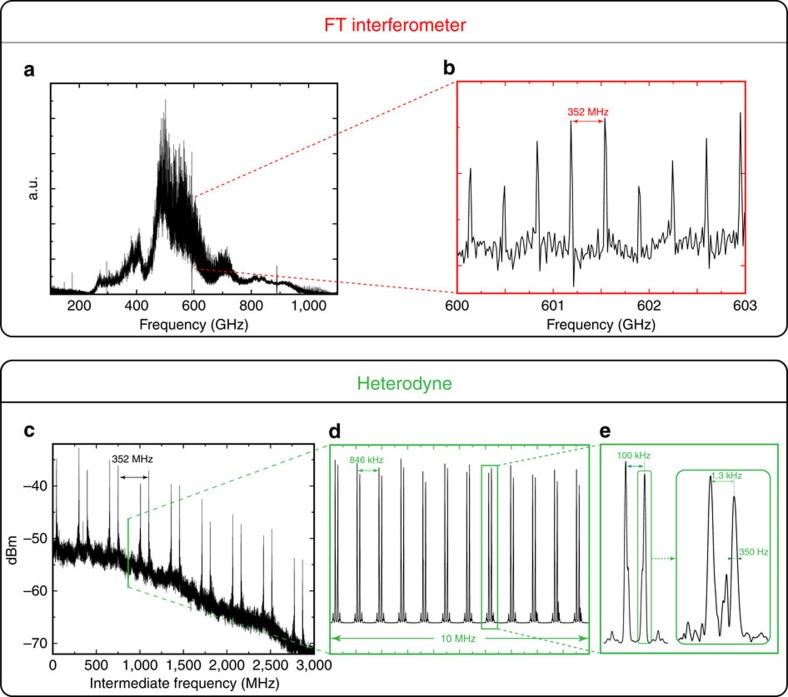
CSR FC structure recorded using the FTIR interferometer and heterodyne receiver.All amplitude scales are linear unless stated otherwise. Heterodyne frequency scales are established as a function of the intermediate frequency. (a) Full range of the CSR measured by the FTIR interferometer with a resolution of 30 MHz; the low-frequency response is limited by the optical elements of the instrument. (b) Zoom of 3 GHz revealing the 352 MHz FC corresponding to 1/Tbunch. (c) Heterodyne spectrum obtained by mixing CSR with fLO=200 GHz. The FC at 352 MHz is also easily distinguished. (d) The second FC composed of sharp teeth regularly spaced by 846 kHz is revealed by an expanded frequency scale. This second comb is produced by the very stable revolution period of the electron bunches in the storage ring (1.18 μs). (e) A zoom of a given dual comb structure caused by the aliasing of the upper and lower frequency bands. (e), inset: the excellent resolving power of the frequency scale allows the detailed examination of a single tooth, highlighting the ultrafine splitting due to low-frequency instabilities of the electron bunches.